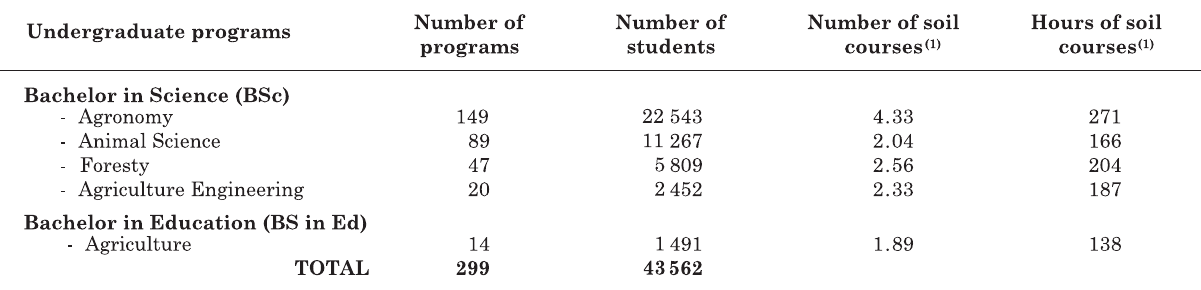
Table 2. Characteristics of undergraduate programs related to Soil Science in Brazil